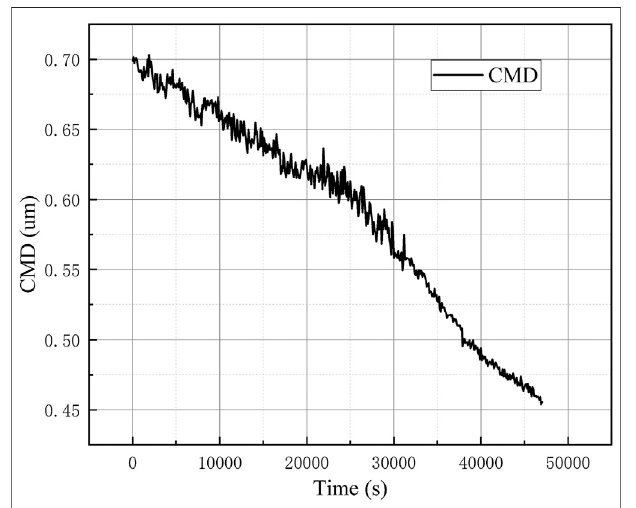
FIGURE 9 | Variation of decay constant with particle size. Electrostatic